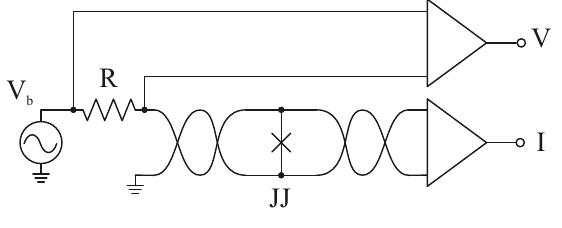
Figure 5. A scheme of the experimental setup.